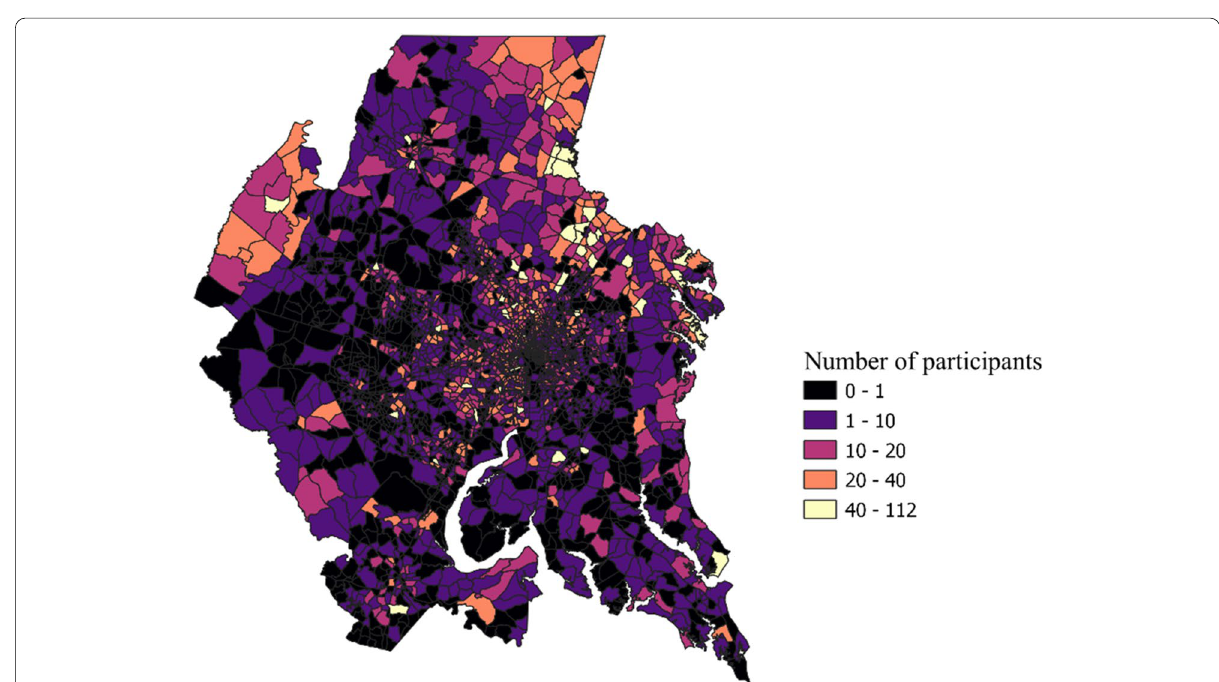
Fig. 1 The spatial distribution of the participants at the scale of TAZ